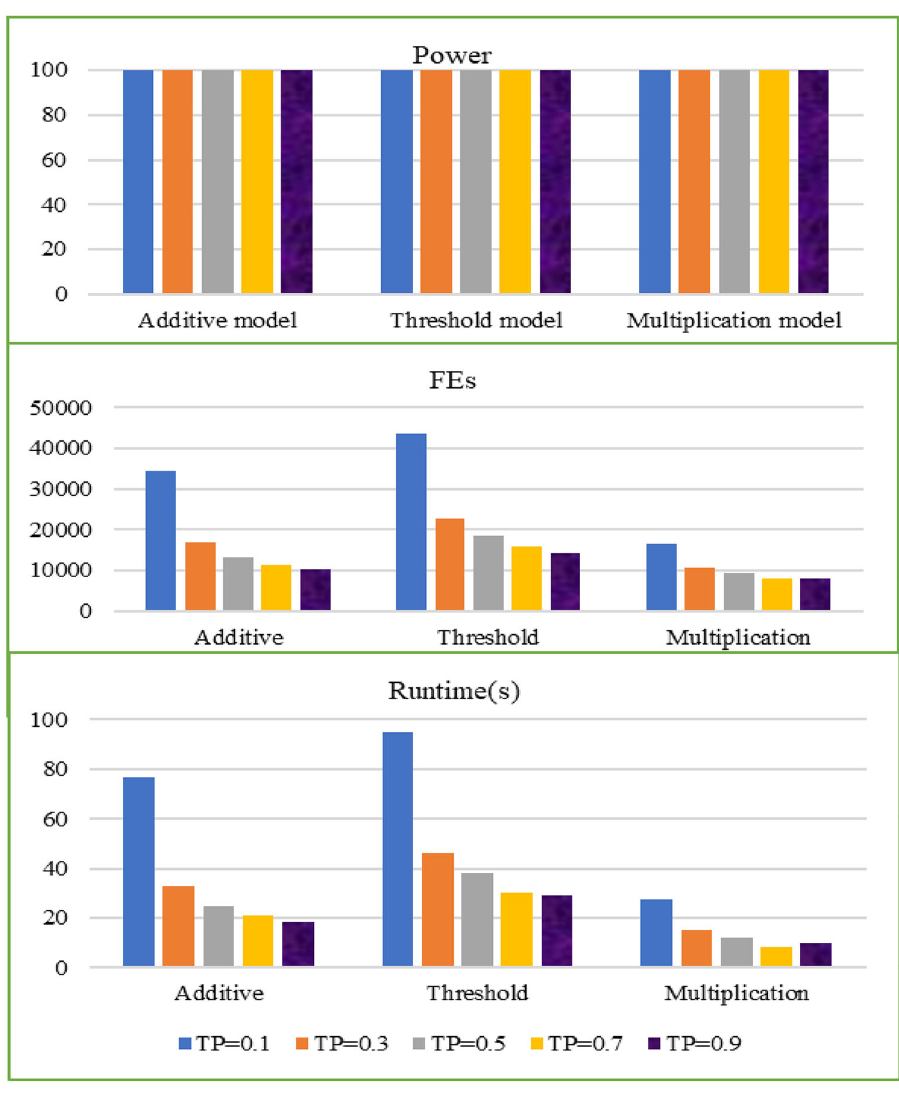
Fig. 4 Effect of TP on the performance of MTHSA-DHEI for detecting EIME